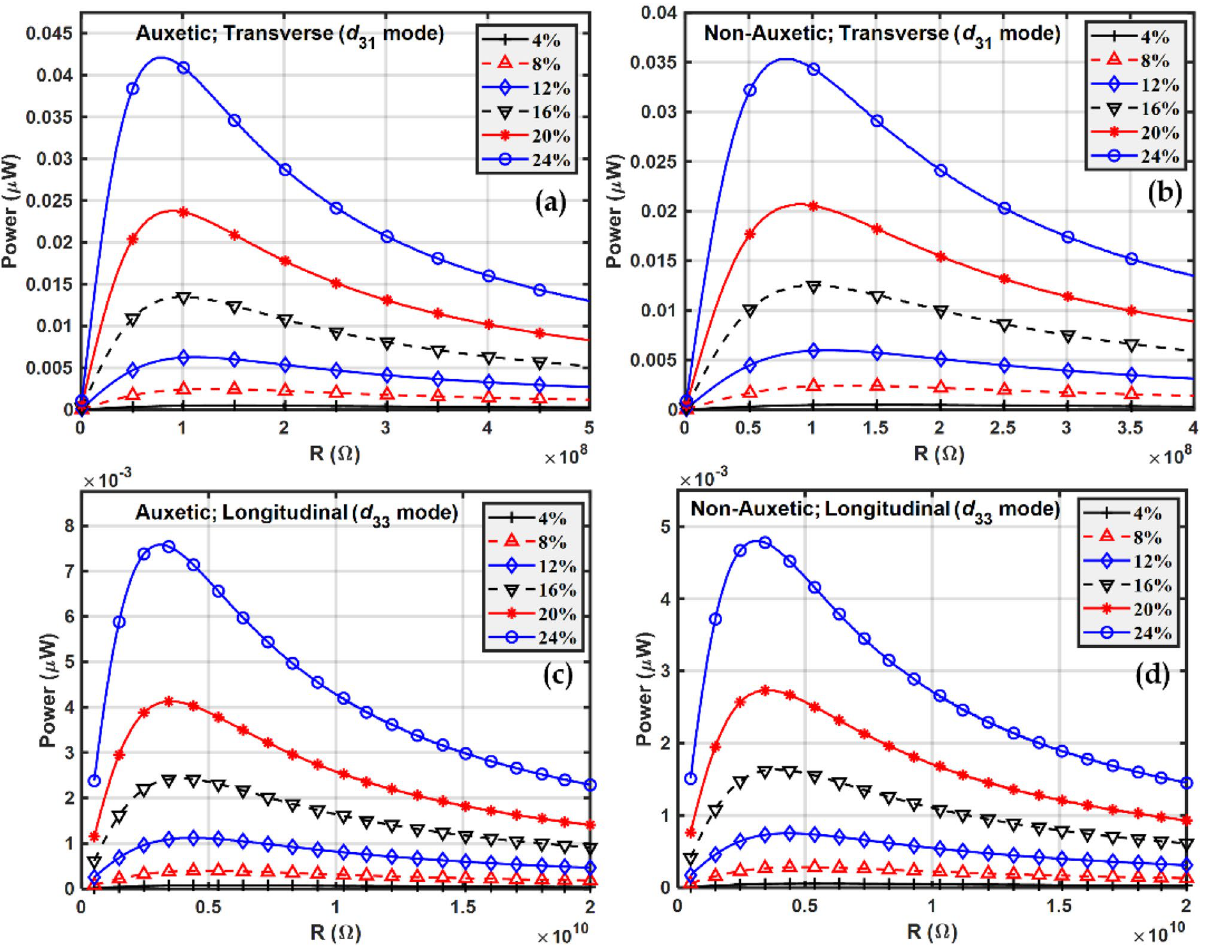
Figure 10. Power vs Resistance at different volume fractions of BCZT in transverse d 31 mode of ( a ) Auxetic ( b ) Non-Auxetic; and in longitudinal ( d 33 ) mode ( c ) Auxetic ( d )